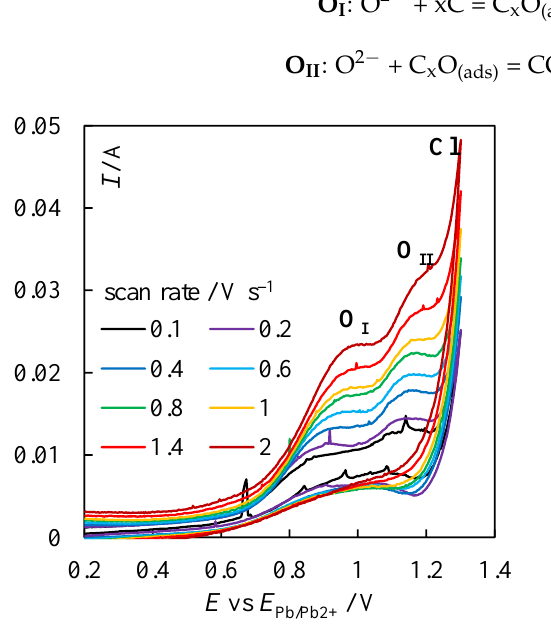
Figure 2. CVs in the initial PbCl 2 melt without the external addition of PbO at a potential sweep rate from 0.1 to 2 V s −1 and a temperature of 520 °C.